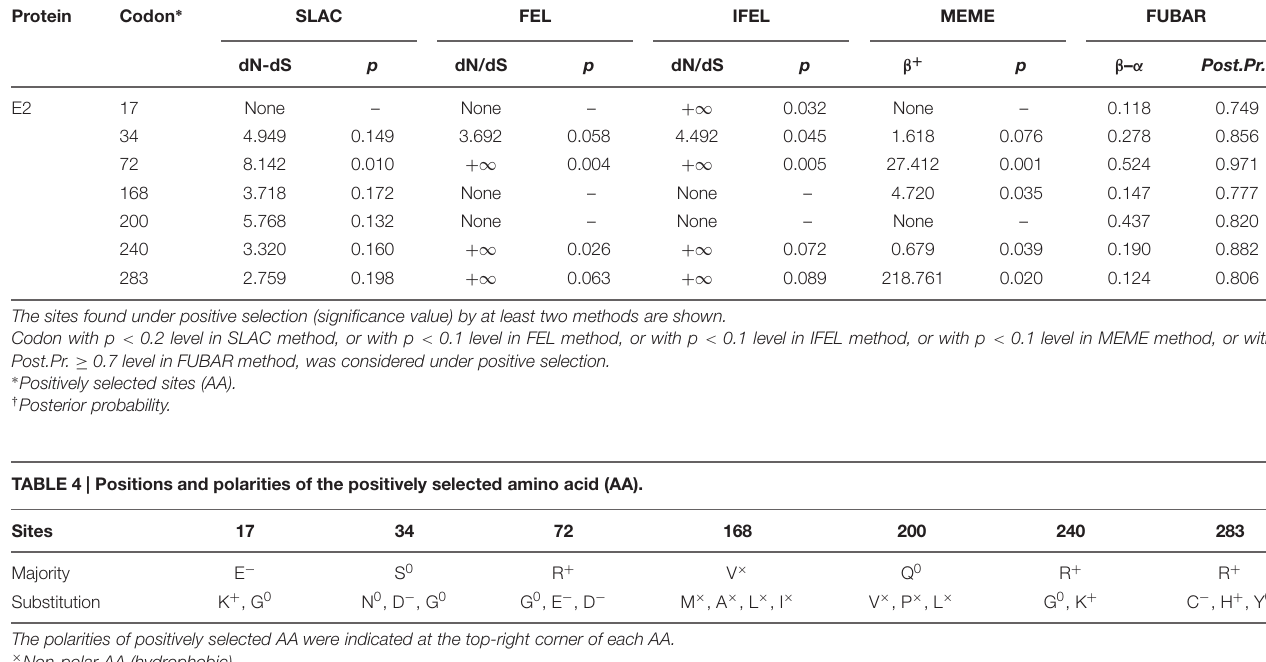
TABLE 3 | Selection pressure analysis of E2 protein (373 codons) of CSFV using SLAC, FEL, IFEL, MEME, and FUBAR methods (www.datamonkey.org). Protein Codon ∗